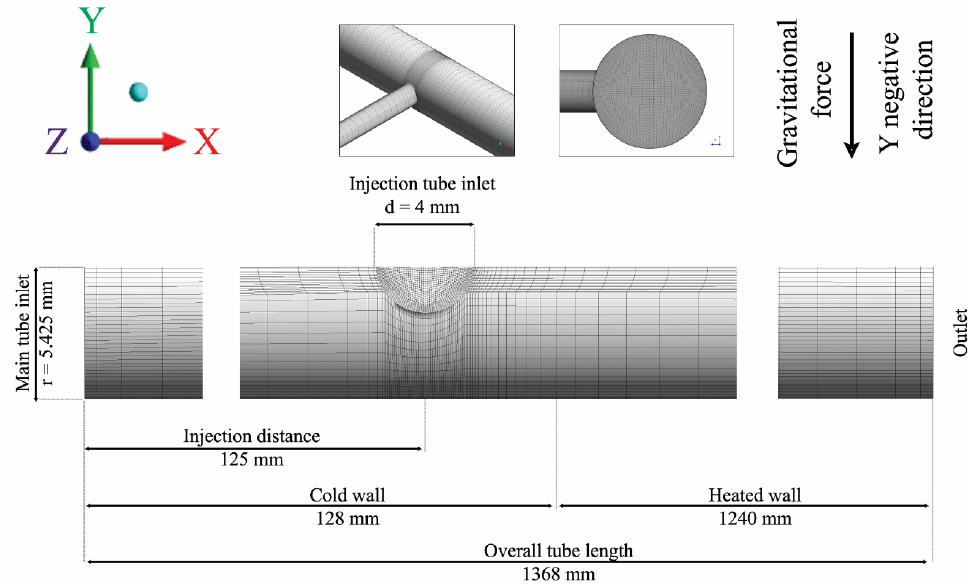
Figure 2. Tee fitting and injection zone [66]. Reprint with permission from ref. [66]. Copyright 2017